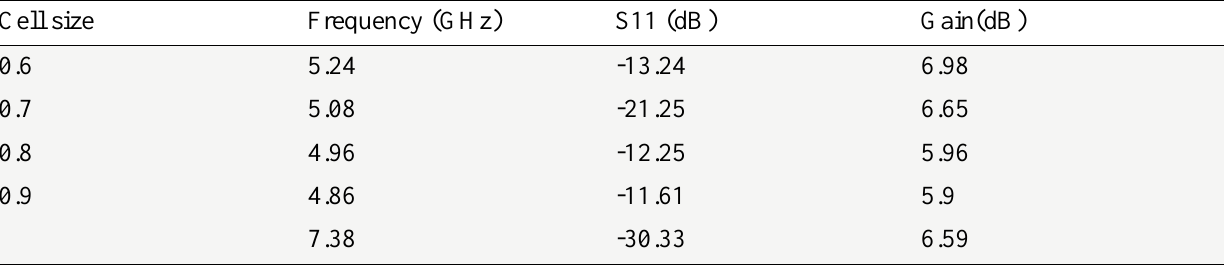
Table 7. Changing the cell size